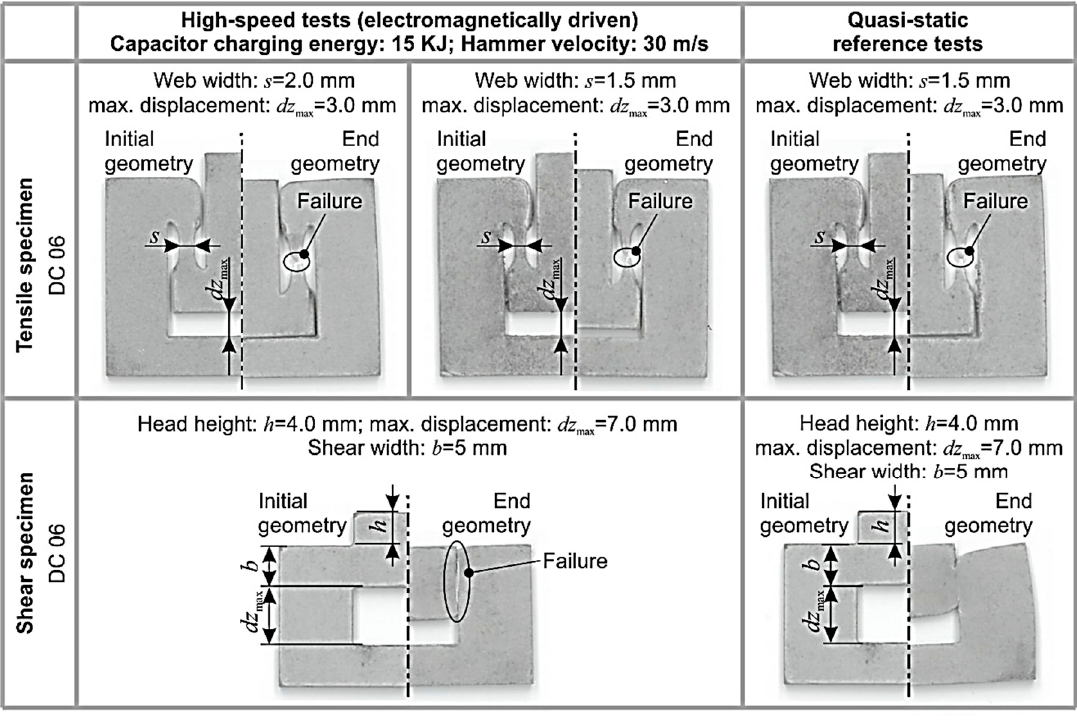
Figure 1. Deformation of exemplary specimen geometries.